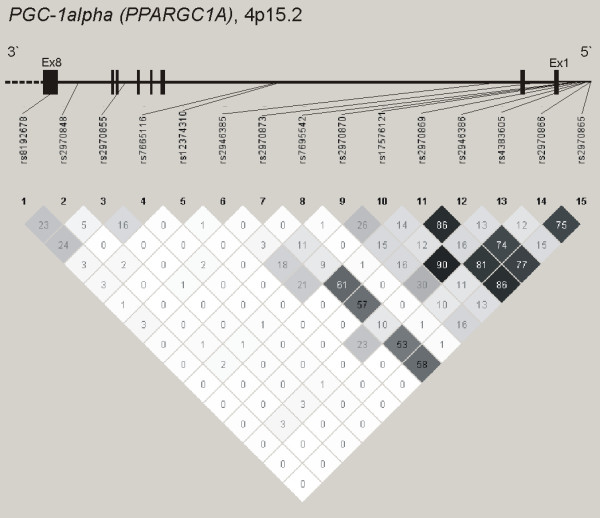
Schematic representation of the PGC-1alpha gene and linkage disequilibrium (r2) in the analysed HD cohort. Black boxes and a horizontal line represent exons and introns respectively. The numbers in the cells denote the r2 between the two SNPs corresponding to the cell. Cell shading indicates strength of r2 as shown by the number.